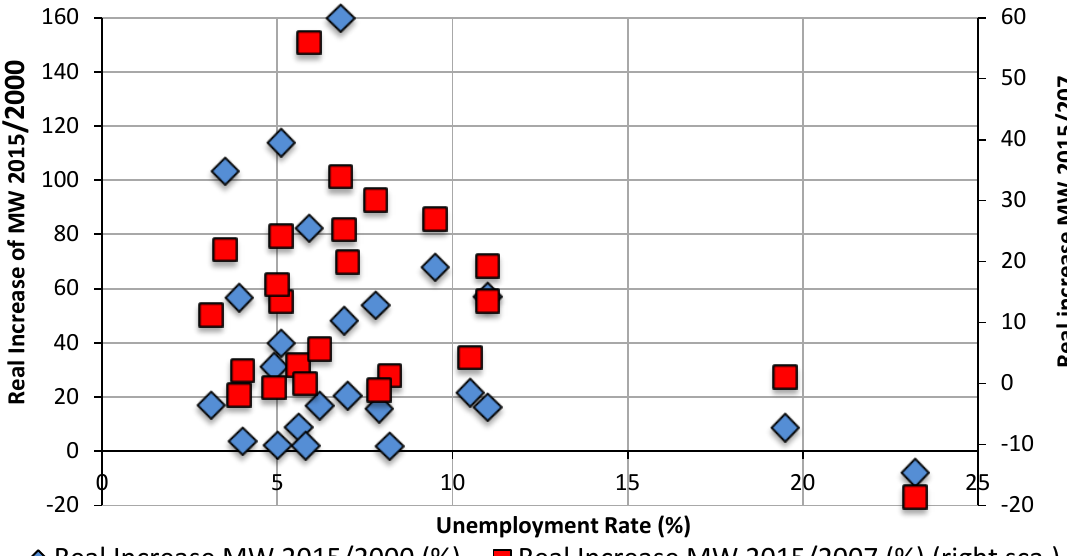
Figure 3. Real Increase of the Minimum Wage (2015/2000 and 2015/2007) and the Unemployment Rate in OECD countries. Source: Own elaboration based on OECD